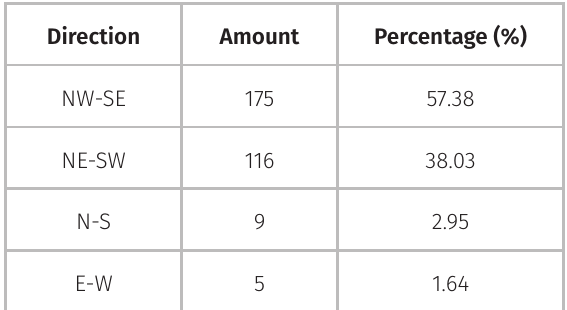
Table V. Statistical analysis of linear features manually extracted manually in the shaded relief